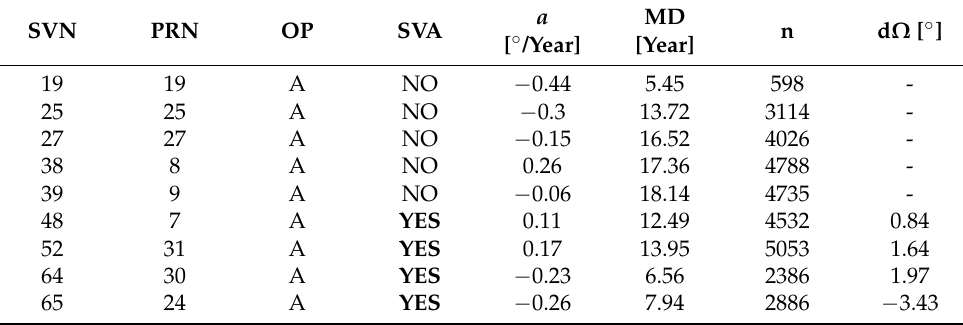
Table A1. Descriptive parameters of the OP A